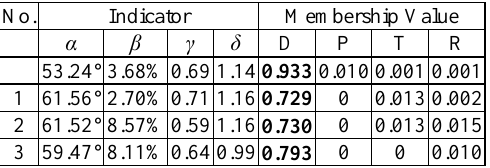
Table 4 Assessment result of dendritic case